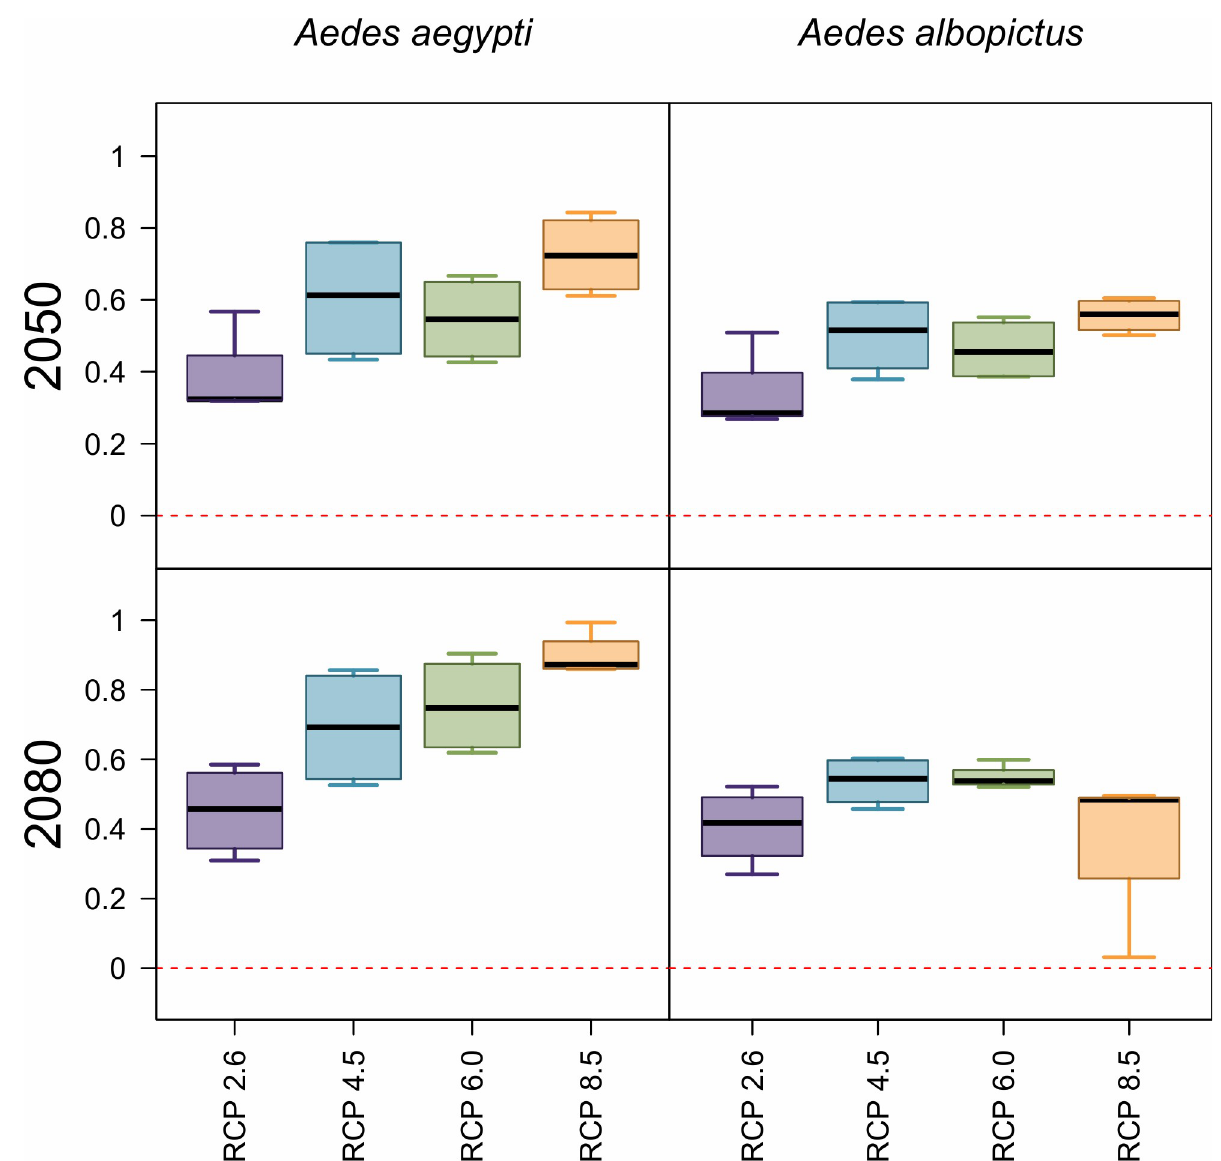
Fig 3. Projected net changes in population at risk. Projections are given as the net difference in billions at risk, for Ae . aegypti and Ae . albopictus transmission, between current maps and 2050 (top row) or 2080 (bottom row). Results are further broken down by representative climate pathways (RCPs), each averaged across 4 general circulation